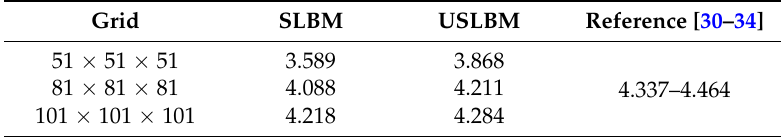
Table 9. Average Nusselt number on the wall for 3D natural convection in Ra = 10 5